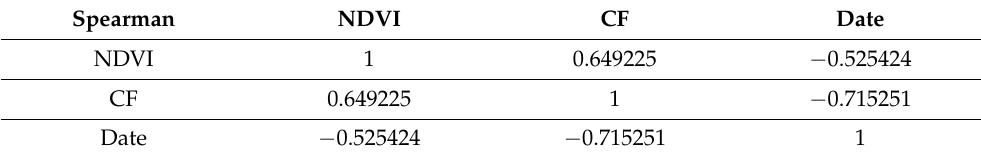
Table 3. Spearman correlation